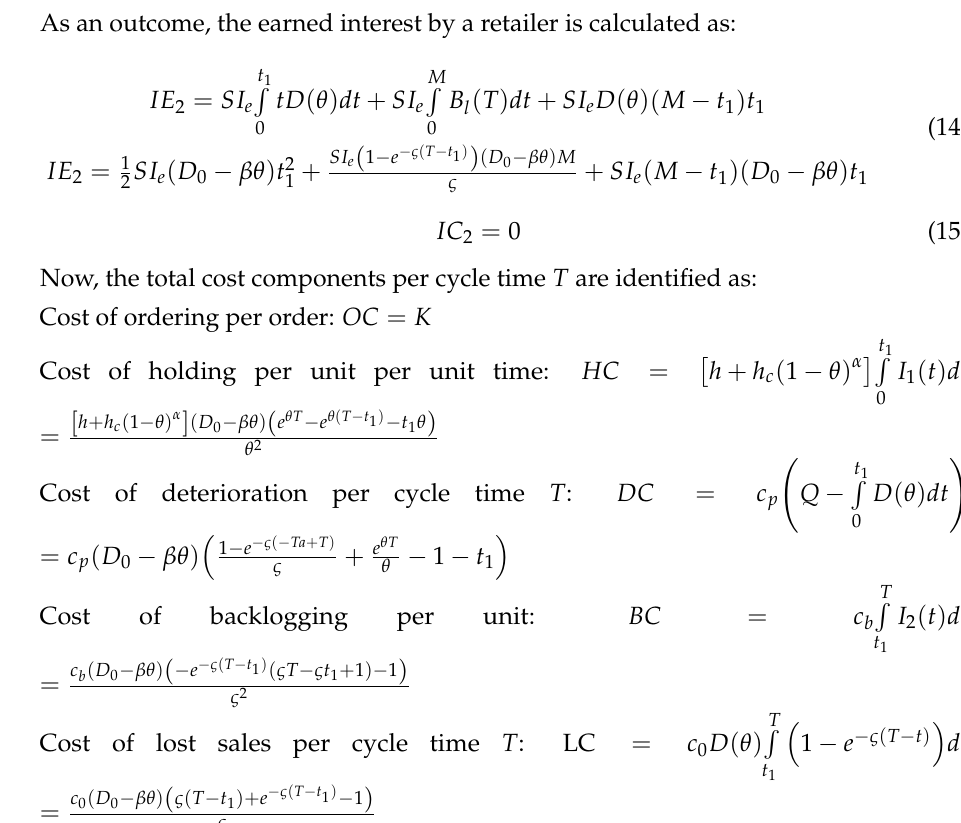
Figure 3. Interest earned when ( 0 < t 1 < M )